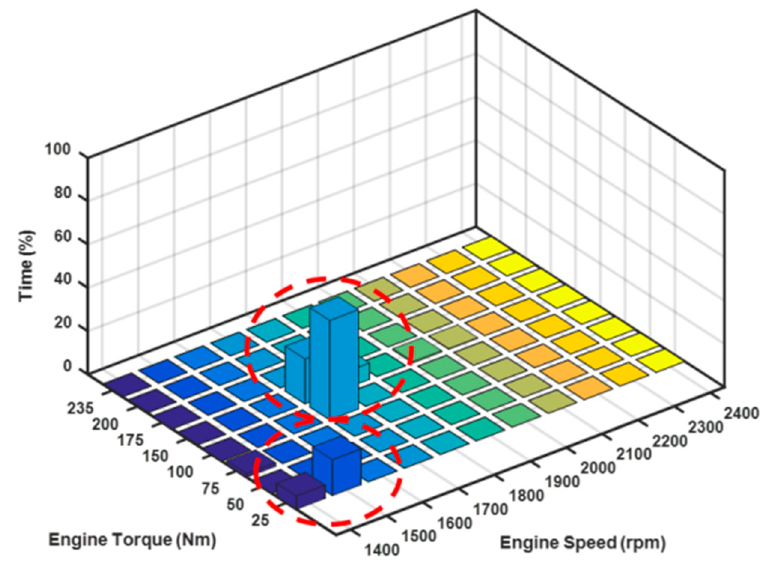
Figure 17. Engine operating time in highway driving cycle with baseline model.